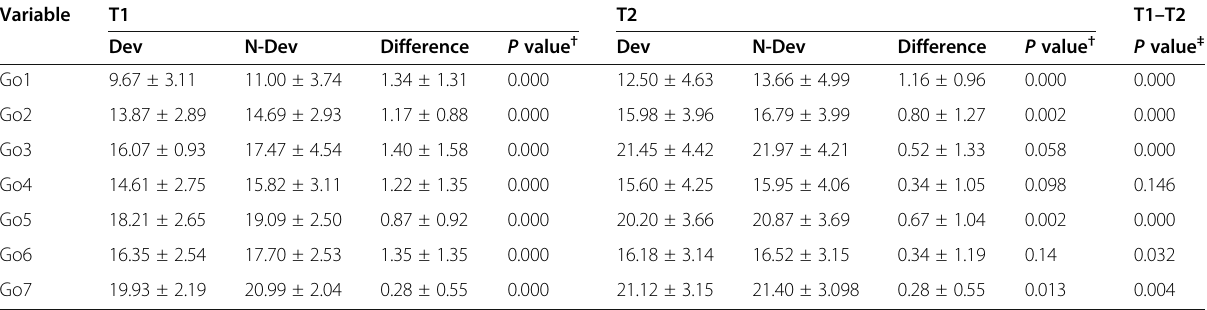
Table 3 Comparison of facial soft tissue thickness between deviated (Dev) and nondeviated (N-Dev) sides before (T1) and 6 months (T2) after surgery Variable T1 T2 T1 – T2 Dev N-Dev Difference P value †